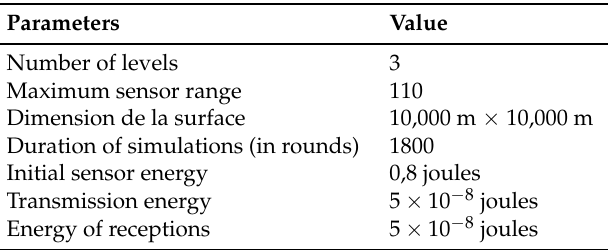
Table 1. Simulation